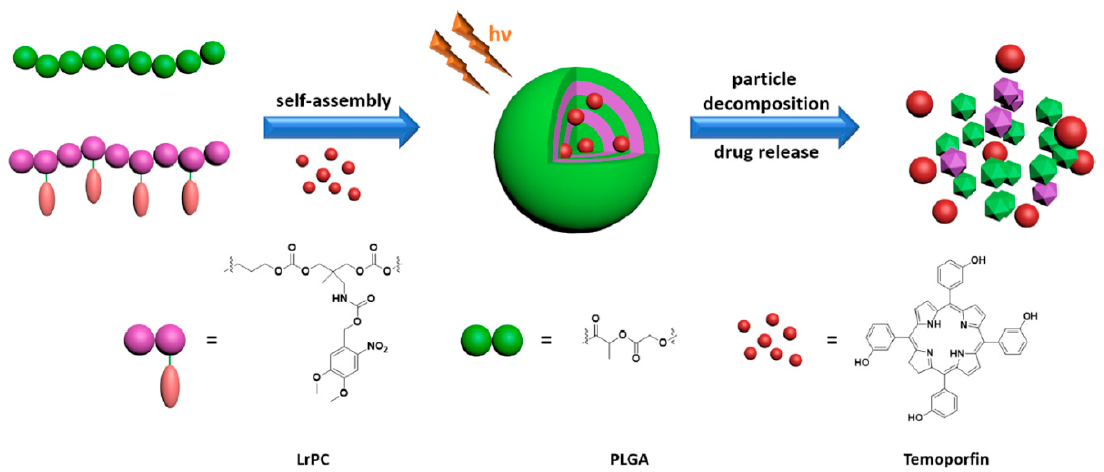
Figure 9. Schematic illustration of the self-assembly of temoporfin-loaded nanoparticles from light-responsive APC and poly(lactide- co -glycolide) and UV light-responsive drug release. Reprinted with permission from ref [147]. Copyright 2018 American Chemical Society.